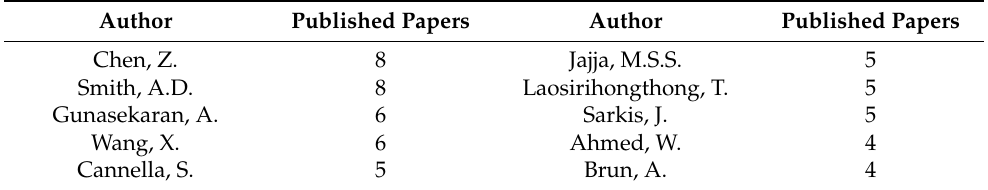
Figure 3. Distribution of keywords other than search keywords in publications (Source: Self-edit).